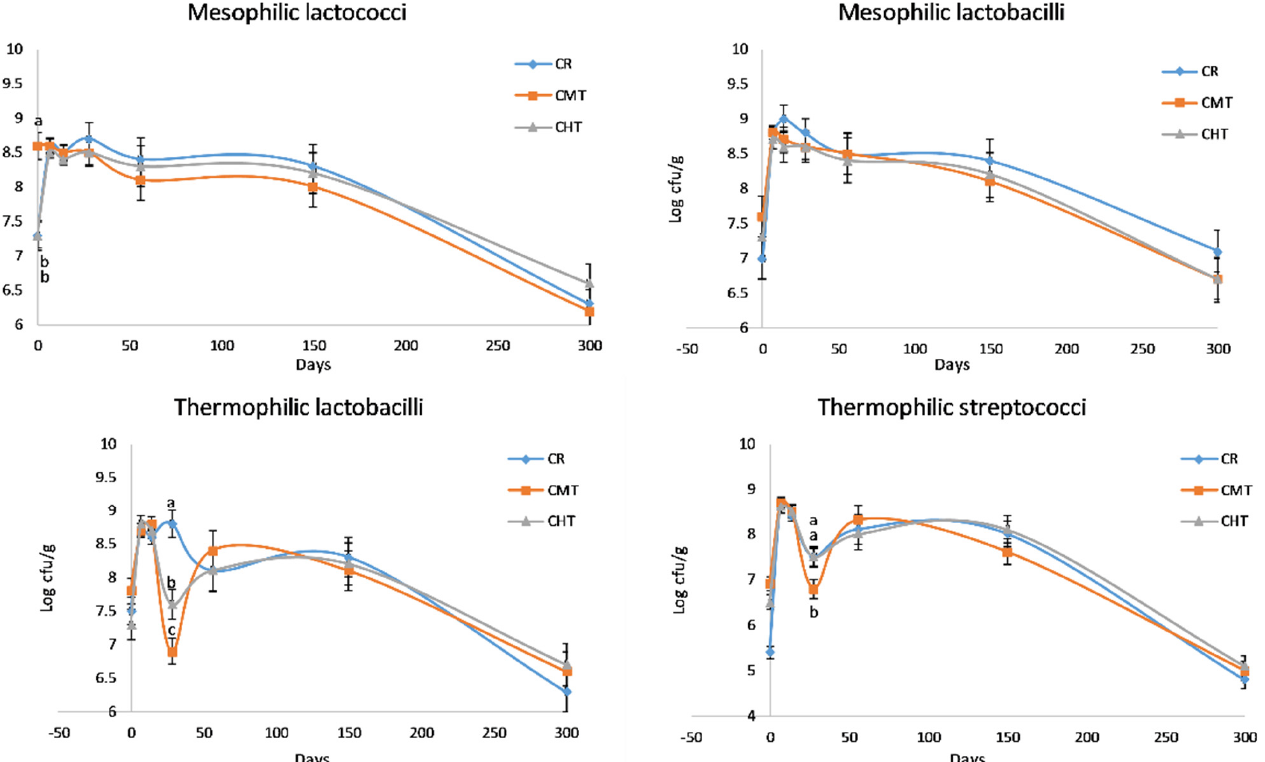
Figure 4. Counts * of the major lactic acid bacteria groups (cfu/g) in Canestrato Pugliese cheeses made from raw (CR), mild-thermized (CMT) and high-thermized (CHT) milk during ripening (0–300 days). Mean values of two analyses on two cheese wheels for each type of cheese.